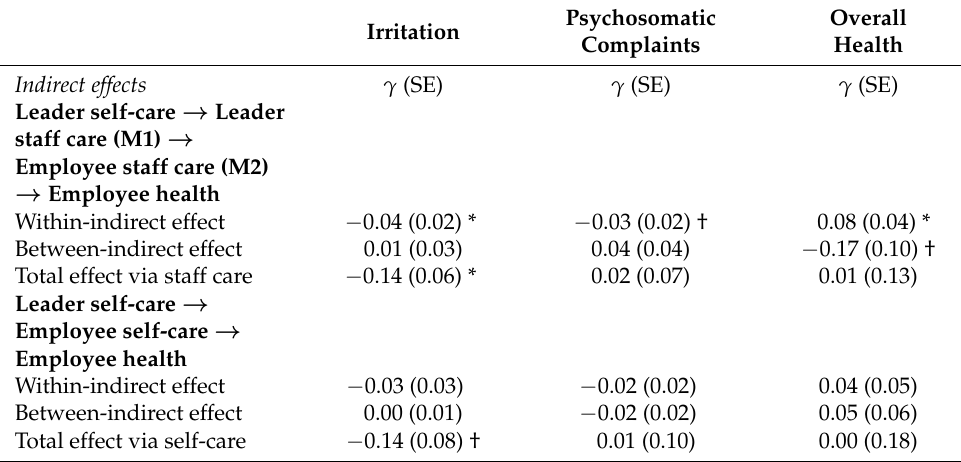
Table 3. Unstandardized indirect effects from multilevel path analysis of irritation, psychosomatic complaints, and overall health. Psychosomatic Irritation